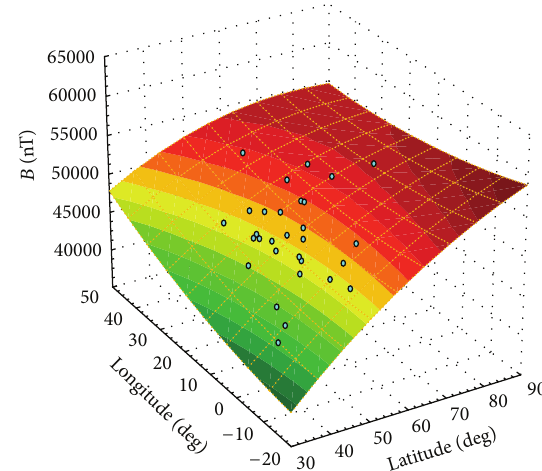
Figure 6: The MGF distribution functions in Europe in 2006.